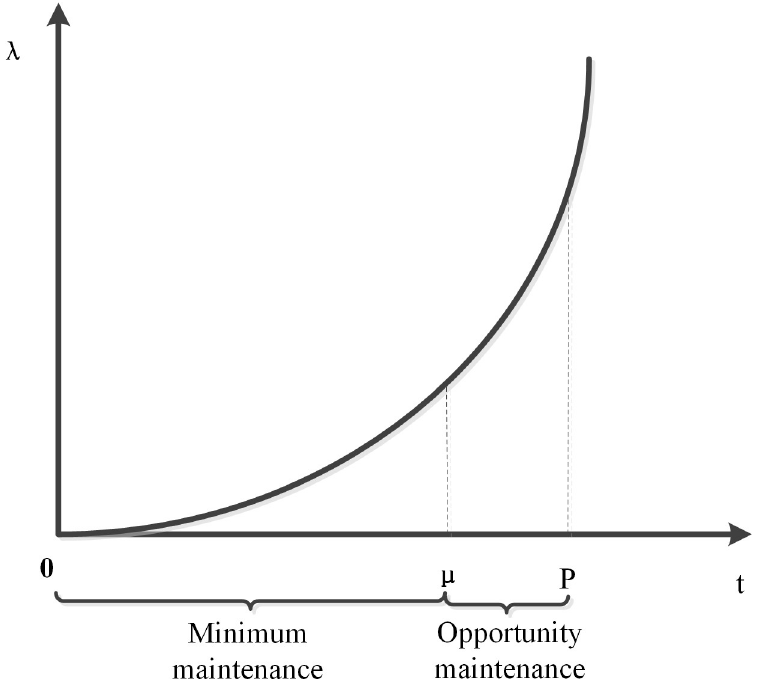
Fig 2. Timed Event opportunity maintenance